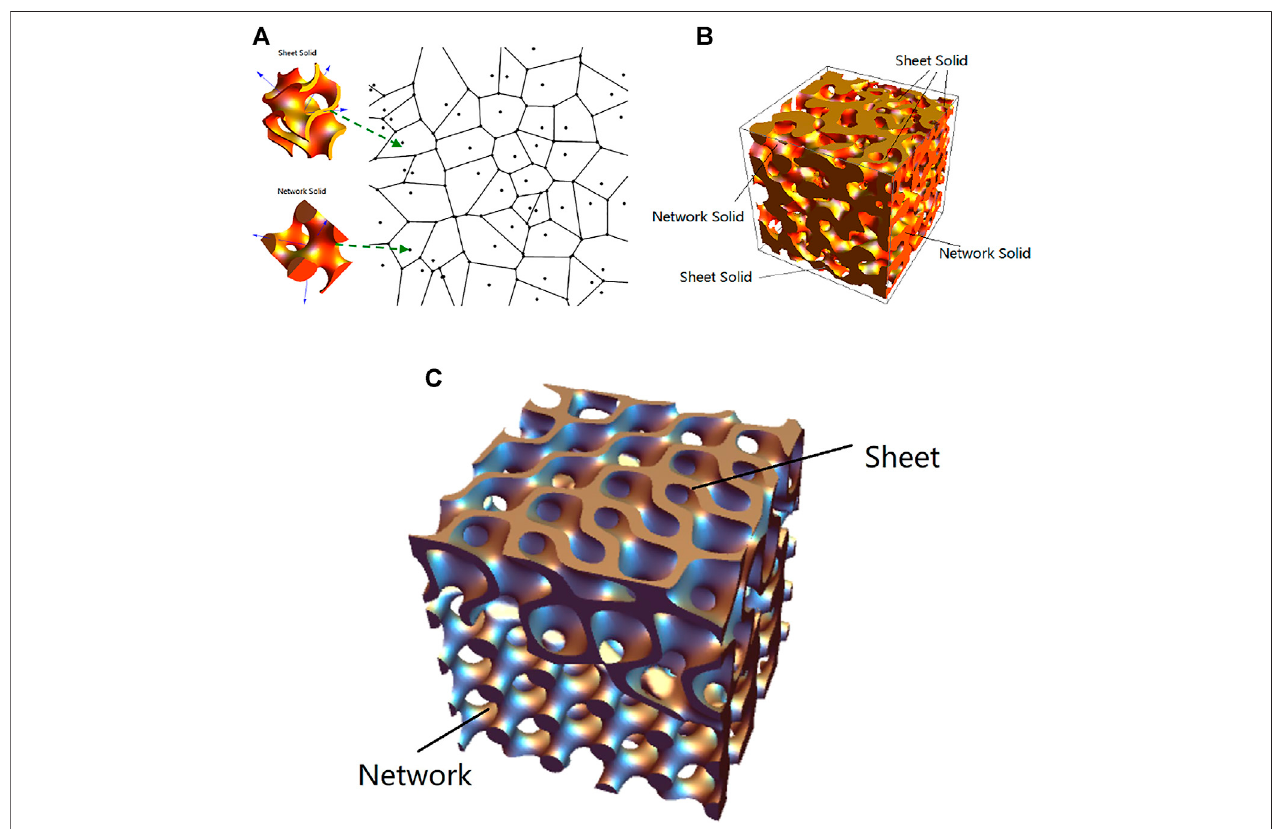
FIGURE 1 | Construction of TV structure. (A) Randomly rotated sheet solids and network solids are assigned as substructures into the randomly chosen Voronoi cells. (B) The resulting TV structure comprising both sheet solids and network solids. (C) Ampli fi ed transition region between sheet and network solid.